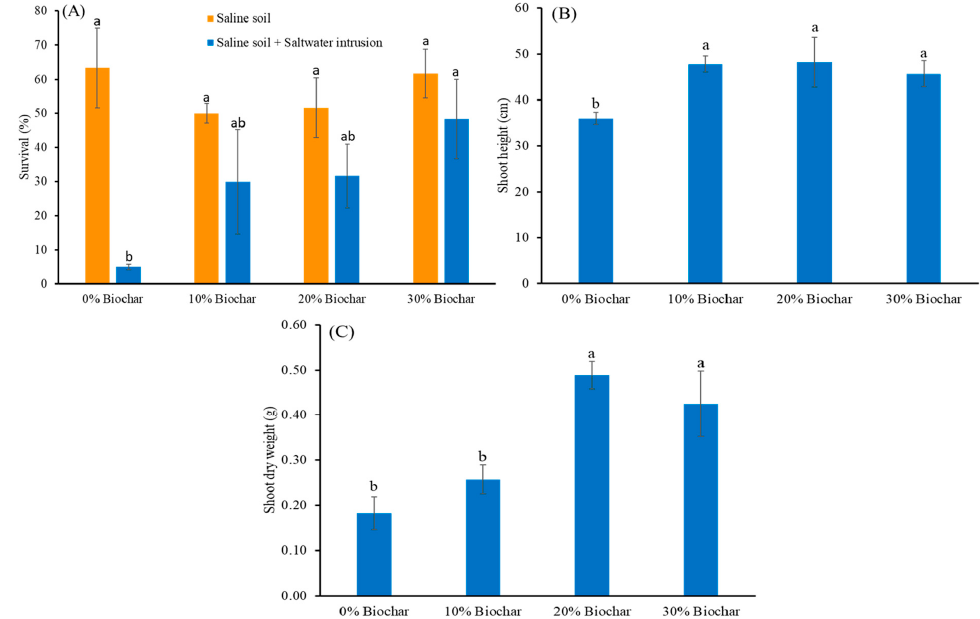
Figure 1. Survival percentages ( A ), shoot heights ( B ), and shoot dry weights ( C ) of Phitsanulok 2 rice grown in saline soil with saltwater intrusion and different rates of biochar application. Data are means ± SE (n = 3). Bars with different letters are significantly different at p < 0.05 according to DMRT. 3.2. Ion Accumulation in Shoots of Rice after Saltwater Intrusion at the Seedling Stage Na + concentrations in the shoots of rice grown in salt-stressed soil with saltwater in- trusion for 28 days were 25.6, 26.7, and 27.0 mg/gDW for the treatments with 0, 10, and 20% (w/w) biochar amendments, respectively (Figure 2A). The shoot Na + concentration was significantly decreased to 13 mg/gDW when 30% (w/w) biochar was added to the soil (Figure 2A). The K + concentration in the shoots was 18.2 mg/gDW for the controlled rice seedlings, and it significantly increased to 27.0 and 24.8 mg/gDW with 20% and 30% (w/w) biochar application rates, respectively (Figure 2B). The shoot Na + /K + ratio for rice under salt stress without biochar was about 1.5 (Figure 2C). Biochar application at rates of 10% and 20% (w/w) did not significantly change the shoot Na + /K + ratio, whereas 30% (w/w) biochar amendment significantly decreased the Na + /K + ratio compared to the control to 0.5 (Figure 2C).